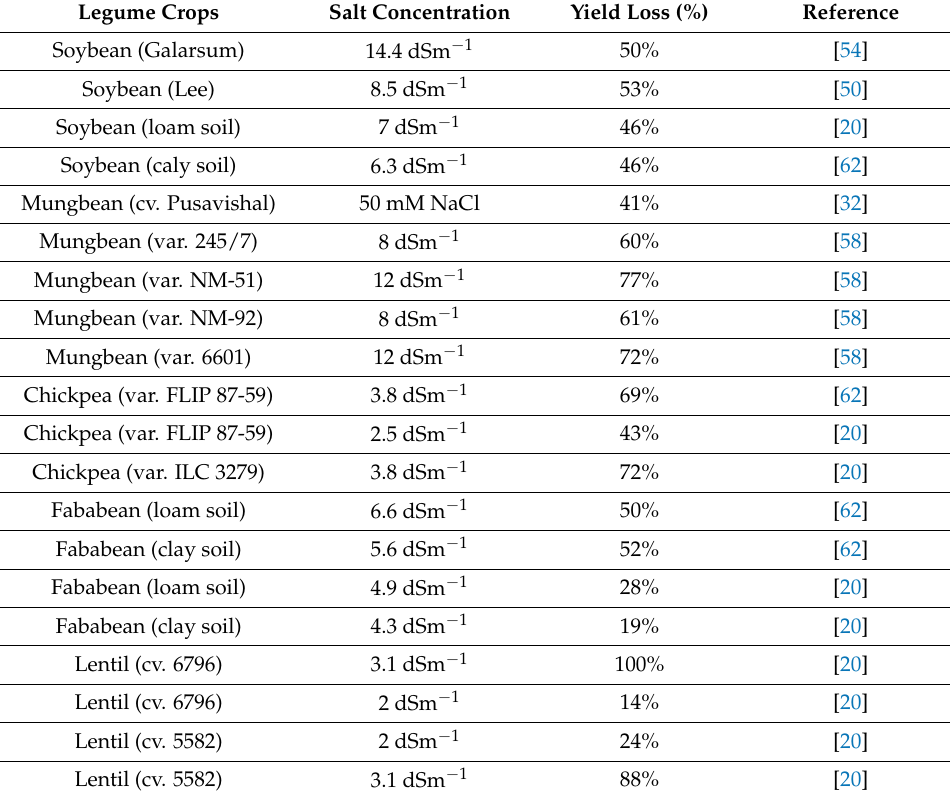
Table 1. Yield reduction under different salinity